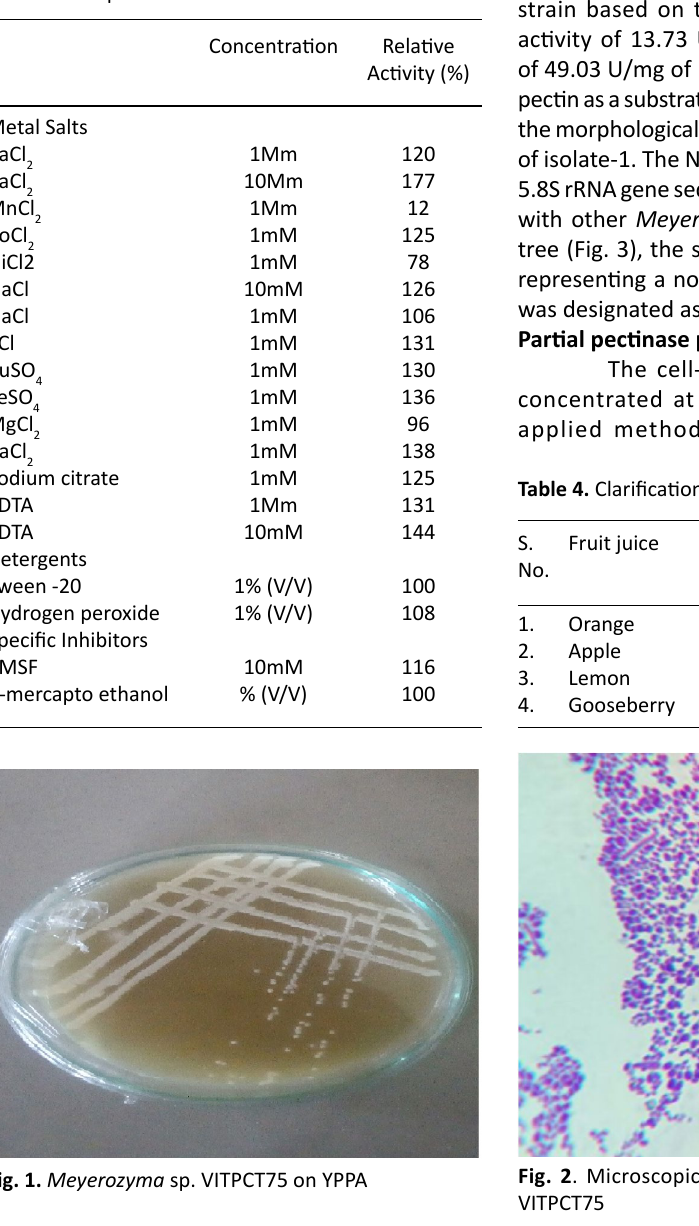
Table 3. Effect of metal ions, detergents and specific inhibitors on pectinase